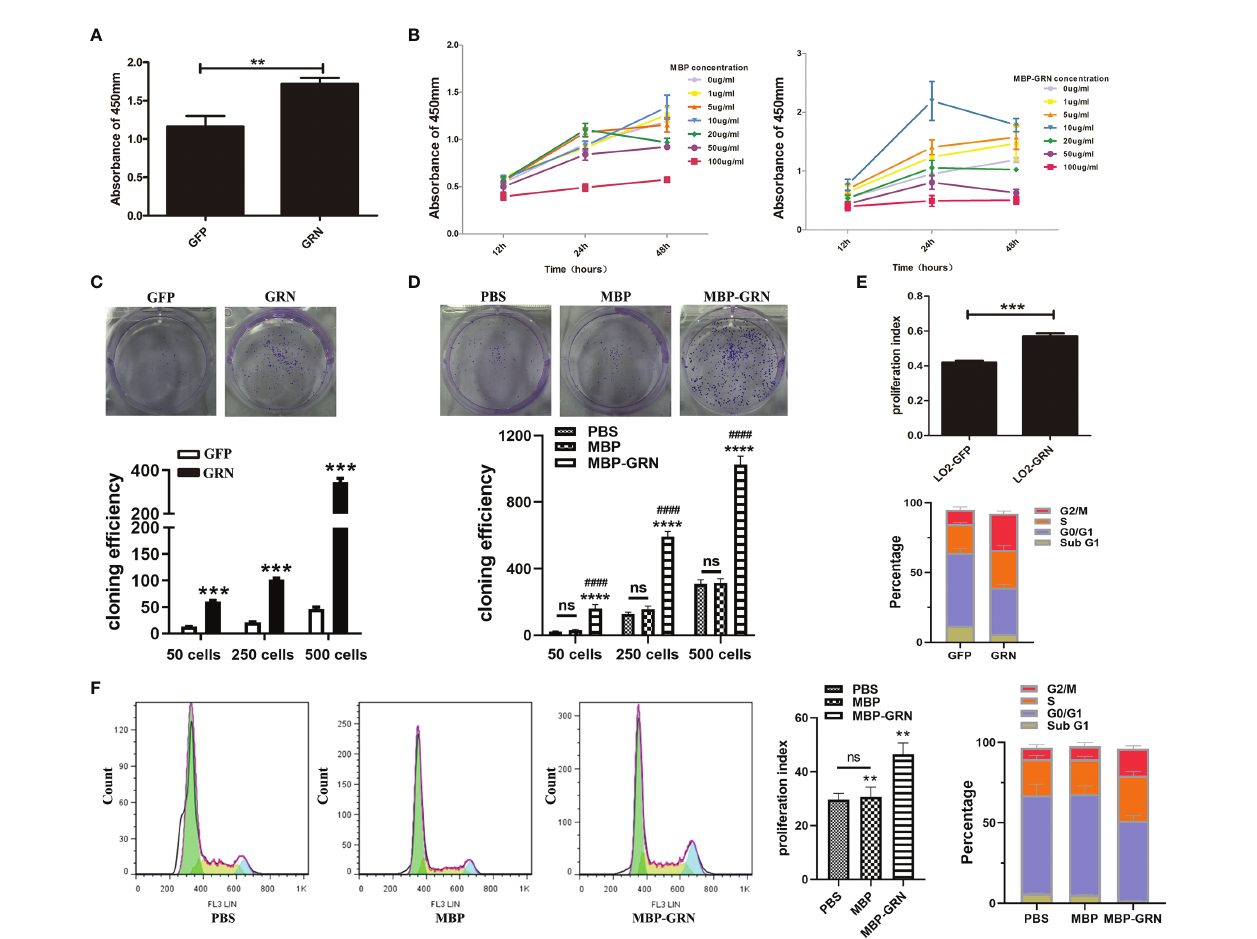
FIGURE 2 | Effects of Cs GRN overexpression on promoting proliferation, colony formation, and cell cycle distribution of LO2 cells. (A, B) Cell proliferation capability of Cs GRN-overexpressed LO2 cells (A) and recombinant Cs GRN protein – treated LO2 cells were detected by CCK8 assay (B) . ** P < 0.01 versus control group. (C) Colony formation assay was performed in Cs GRN-overexpressed LO2 cells. *** P < 0.001 versus control group. (D) Colony formation assay was performed in recombinant Cs GRN protein – treated LO2 cells. **** P < 0.0001 versus control group, #### P < 0.0001 versus MBP group. (E, F) Cell cycle distribution was analyzed by fl ow cytometry. The proliferation index (PI) and the percentage of cell cycle phase in Cs GRN-overexpressed LO2 cells (E) . Histogram of the typical cell cycle, PI, and the percentage of cell cycle phase in recombinant Cs GRN protein – treated LO2 cells (F) . ** P < 0.01 versus control group, *** P < 0.001 versus control group. The data of proliferation index (PI) were calculated by the formula: PI = (S + G2M)/(G0/1 + S + G2M). NS means NO statistic